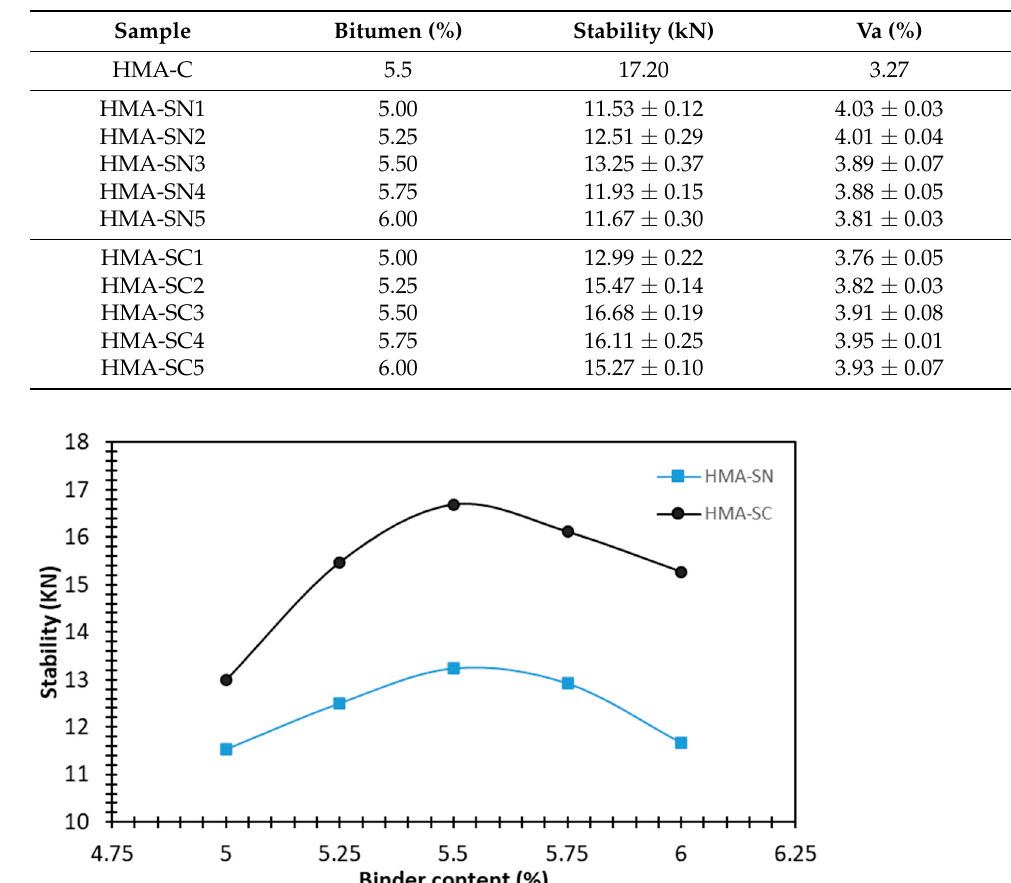
Table 3. Marshall stability and air voids content for HMA mixtures.